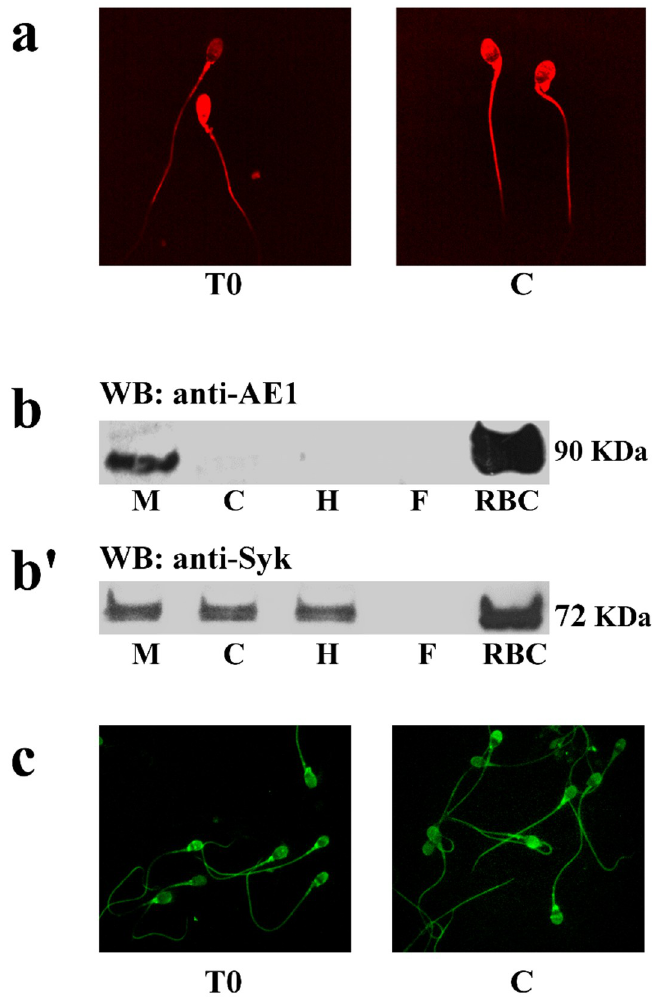
Figure 3. Expression and location of spAE1 and protein kinase Syk. Panel ( a ) Immunofluorescence of spAE1 in sperm incubated under non-capacitating (T0) or capacitating (C) conditions. ( b ) Western blot analysis of the subcellular sperm fractions obtained as described in Methods. Non-capacitated sperm plasma membrane (M), cytosol (C), flagellum (F) or head (H) were subjected to Western blot analysis with antibodies against spAE1 (panel ( b )) or Syk (panel ( b’ )). Panel ( c ) Immunofluorescence detection of protein kinase Syk in sperm incubated under non-capacitating (T0) or capacitating (C) conditions. The figure is representative of 6 separate experiment.